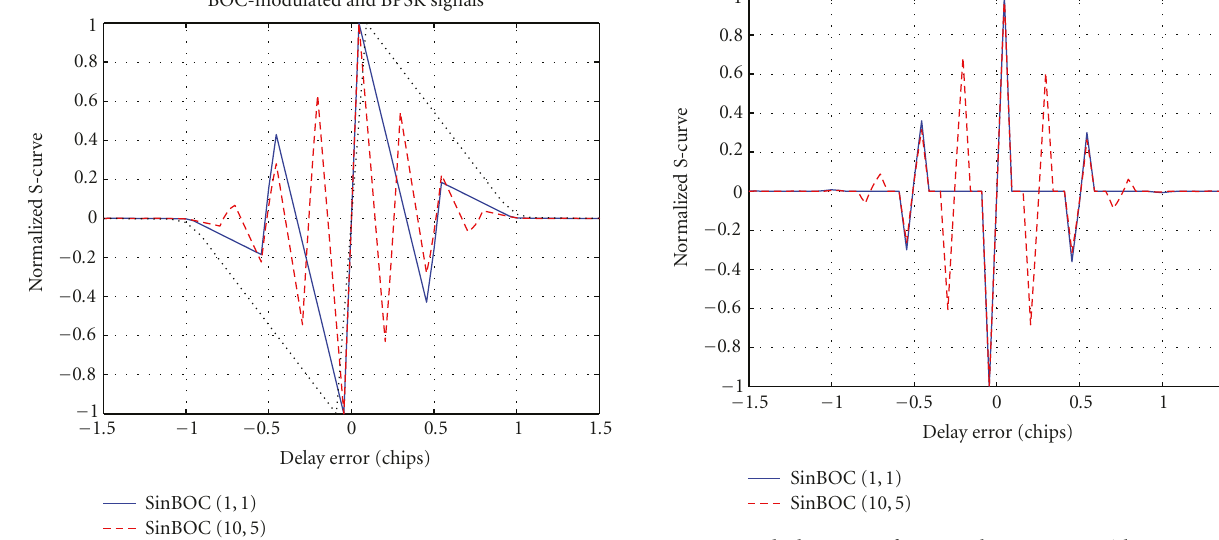
Figure 6: Ideal S-curves for noncoherent HRC with a = − 1 / 2, for two BOC-modulated signals and Δ = 0 . 1